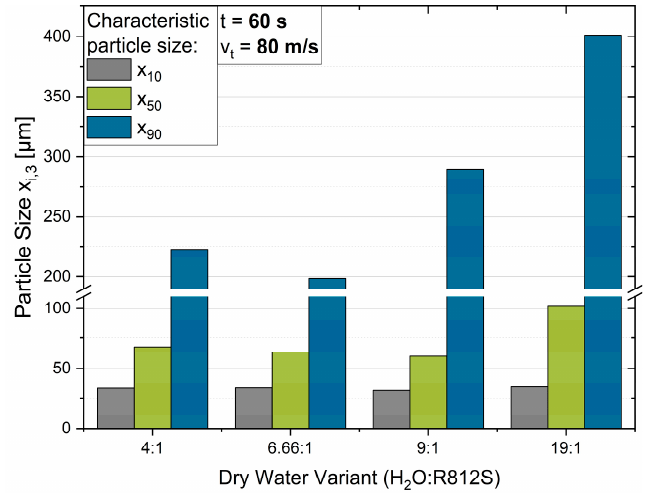
Figure 11. Characteristic particle sizes x 10 , x 50 and x 90 for each dry water variant (ratio H 2 O:R812S) created in a high shear blender at n = 22,000 min − 1 for t = 60 s.